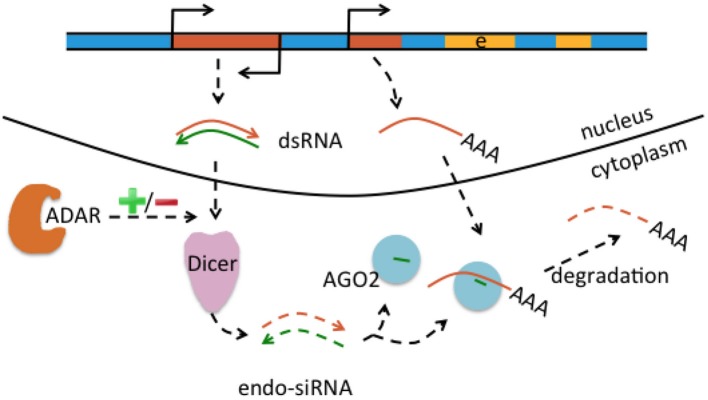
Interaction of RNA editing and retrotransposons at the mRNA level. Retrotransposons (brown boxes) may be transcribed in sense and antisense direction (indicated by promoter symbols pointing in opposite directions), form double-stranded RNA (dsRNA) precursors (brown and green arrows) that are processed by Dicer into endo short interference RNAs (endo-siRNA). Endo-siRNAs (here indicated as short green lines) are loaded onto AGO2 proteins, may detect further single-stranded retrotransposons transcribed from other locations (middle brown brown box) and target them for degradation. Thus, the siRNA pathway contributes to retrotransposon silencing. Levels of endo-siRNA can be affected by ADAR and/or A-to-I editing, with an increase or decrease (indicated by “+/–“) of small RNA upon loss of ADAR.